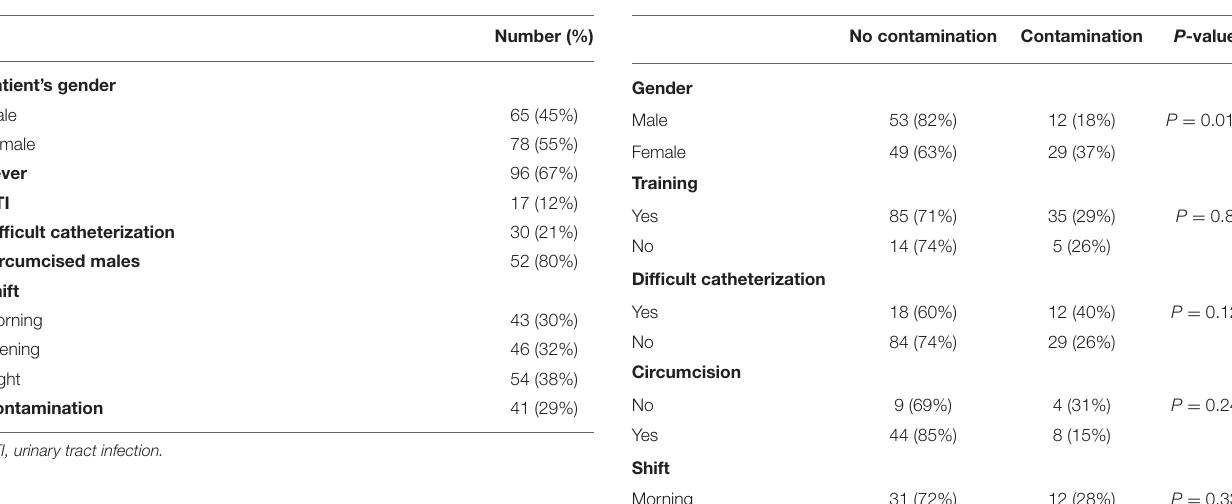
TABLE 1 | Characteristics of the study cohort. TABLE 2 | Comparison between the groups with or without